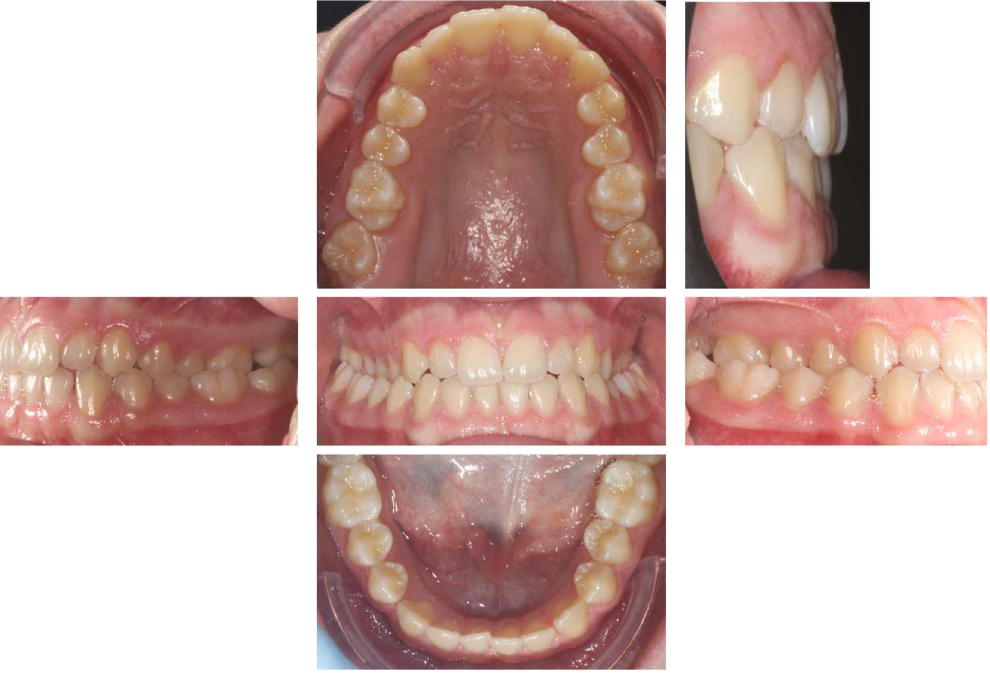
Figure 2: Initial intraoral photographs.